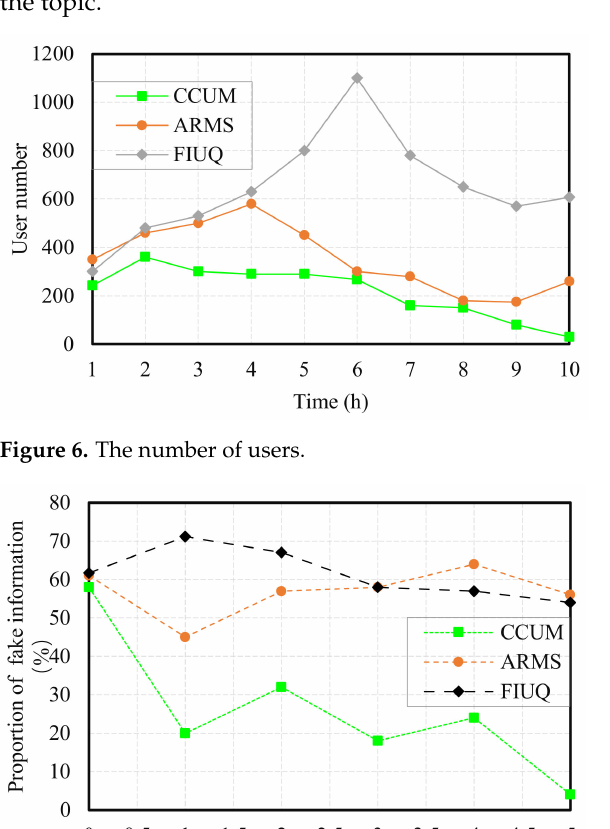
Figure 6. The number of users.